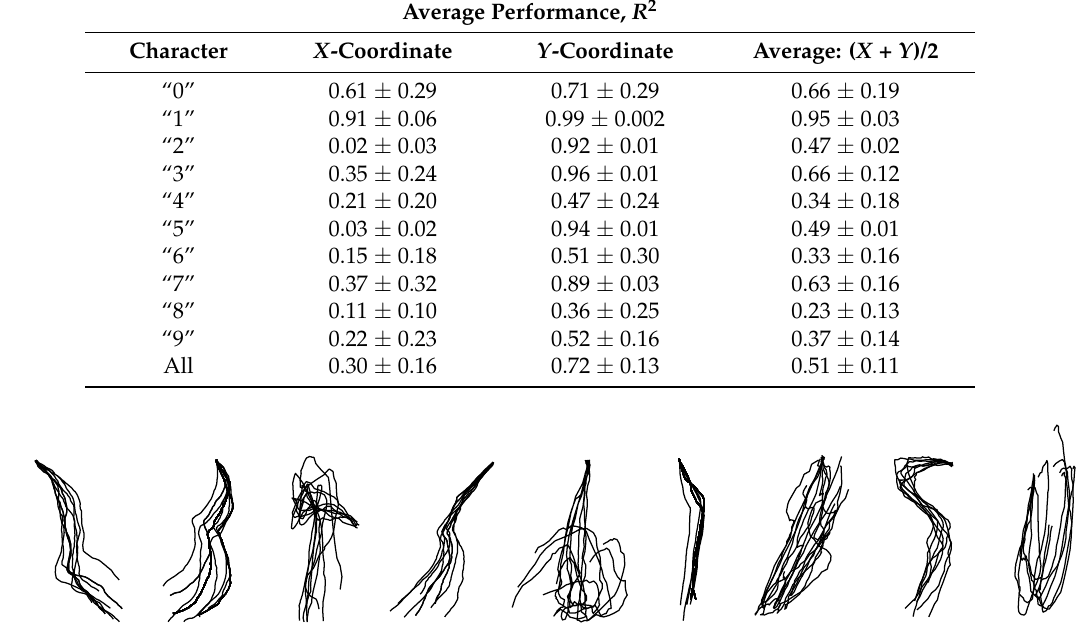
Table 9. Between-group reconstruction performance by the KF: the average accuracy of each numeric character across the five subjects.